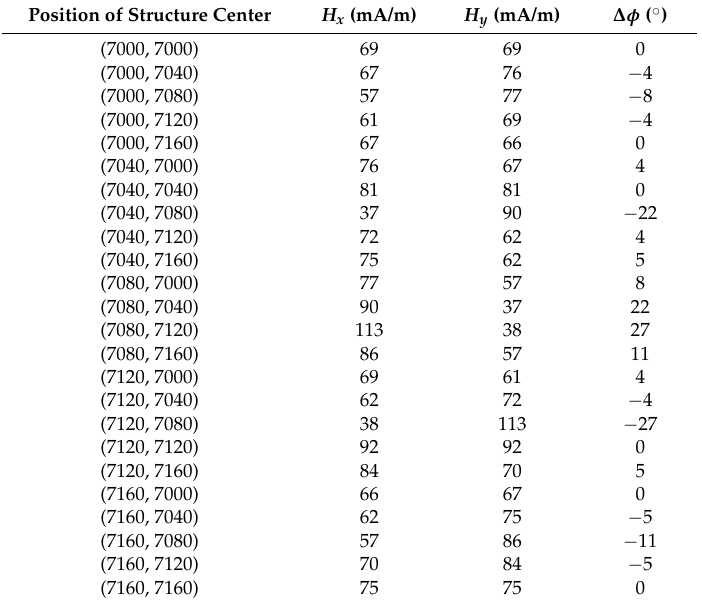
Table 2. FDTD-computed peak values of H x and H y , and azimuth errors estimated from Equation (2) for the case of true azimuth φ equal to 45 ˝ and current risetime equal to 0.5 µ s.